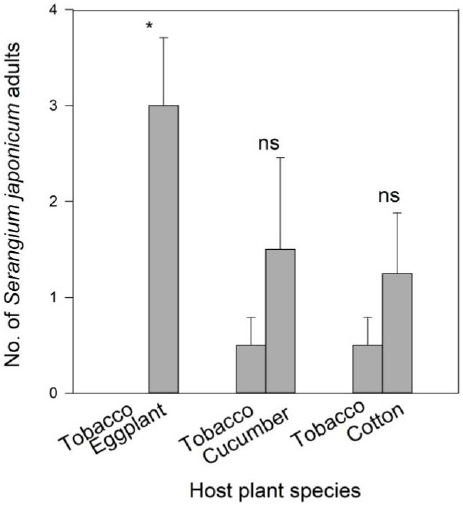
Figure 4. Numbers (mean ± SE) of Serangium japonicum adults on each plant in wind tunnel assays. The asterisk means a significant difference and ns means no difference in each group at p < 0.05.